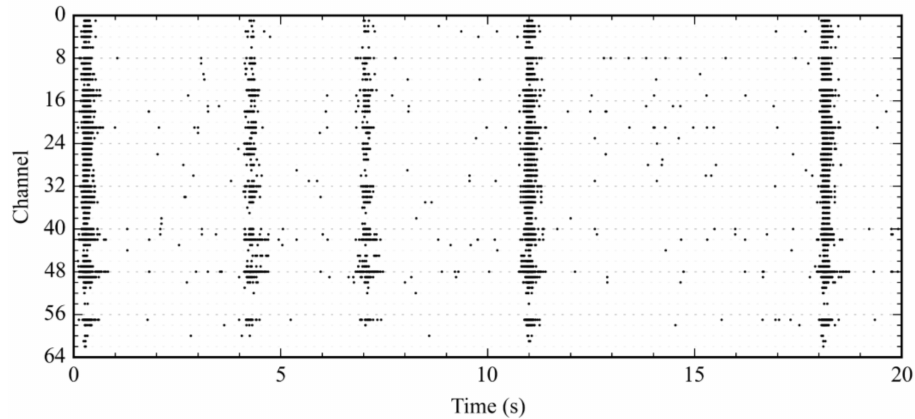
Figure 9. Raster plot of real-time neural AP detection on a patterned culture, recorded on a 60-electrode MEA. In this reading, the average burst contained 11 APs per electrode. The experimenter validated detected events offline.